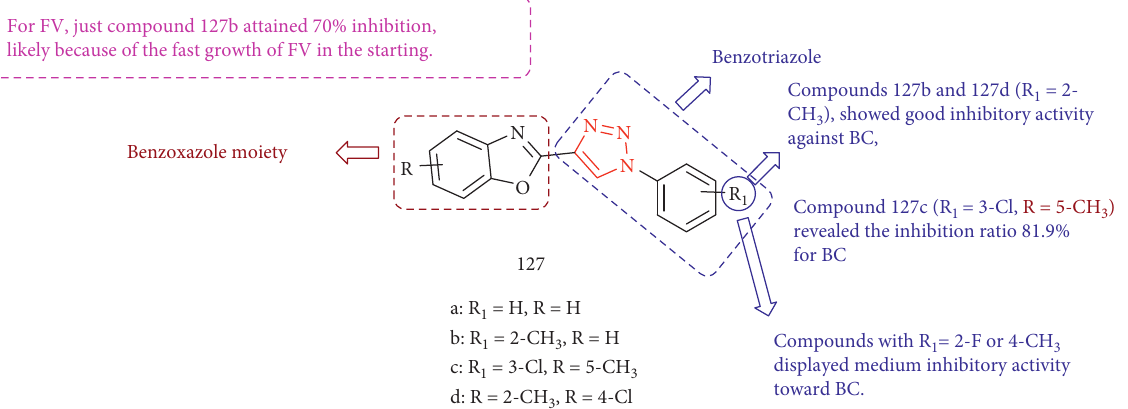
Figure 62: Chemical structure of novel benzoxazole derivatives containing a 1,2,3-triazole moiety.